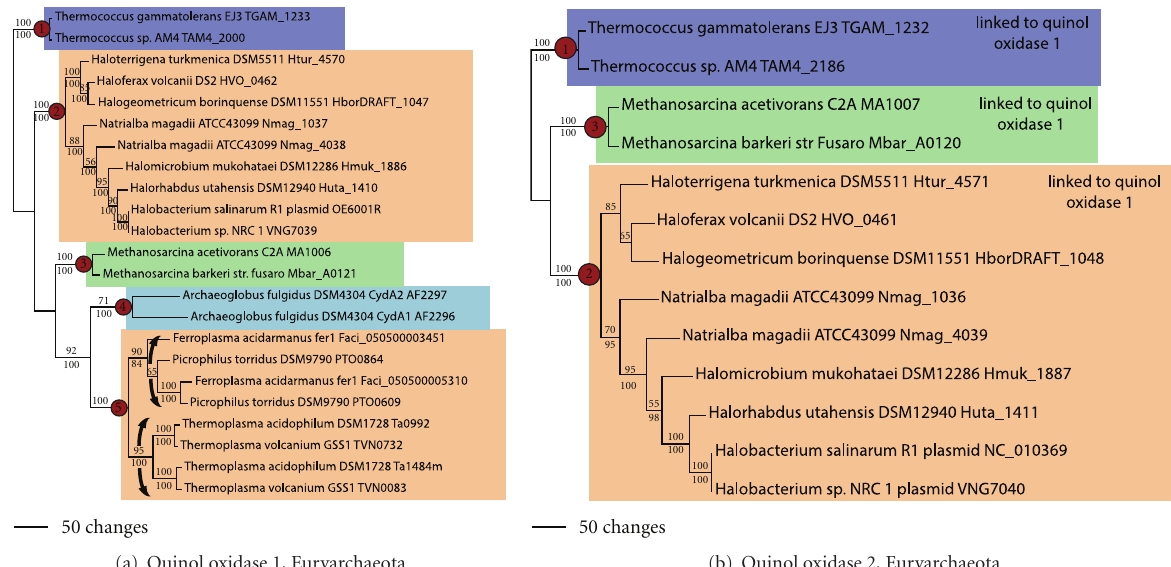
Figure 4: Cytochrome oxidase bd quinol oxidase in the Euryarchaeota. Phylogenetic trees for (a) quinol oxidase subunit 1 and (b) quinol oxidase subunit 2. Bootstrap values above 50% from MP analyses are shown above each branch; posterior probabilities from MB analyses are shown below each branch.